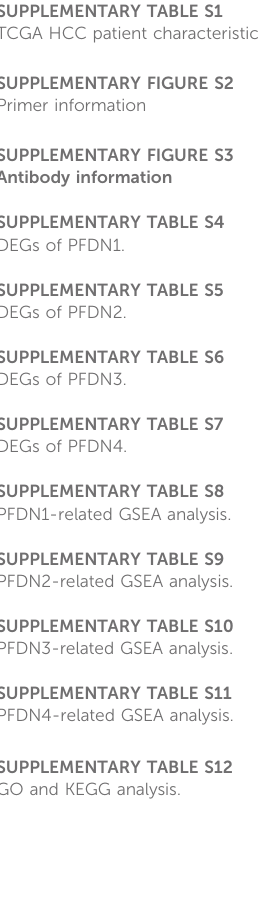
SUPPLEMENTARY FIGURE S1 ROC curves of the PFDN family in HCC. The ROC curves of PFDN1 – 6 (A – F) in HCC. SUPPLEMENTARY FIGURE S2 Scatter plots indicate the correlations between PFDN1/2/3/4 expression and (A) Th2 cells and (B) TFH cells. SUPPLEMENTARY TABLE S1 TCGA HCC patient characteristics. SUPPLEMENTARY FIGURE S2 Primer information SUPPLEMENTARY FIGURE S3 Antibody information SUPPLEMENTARY TABLE S4 DEGs of